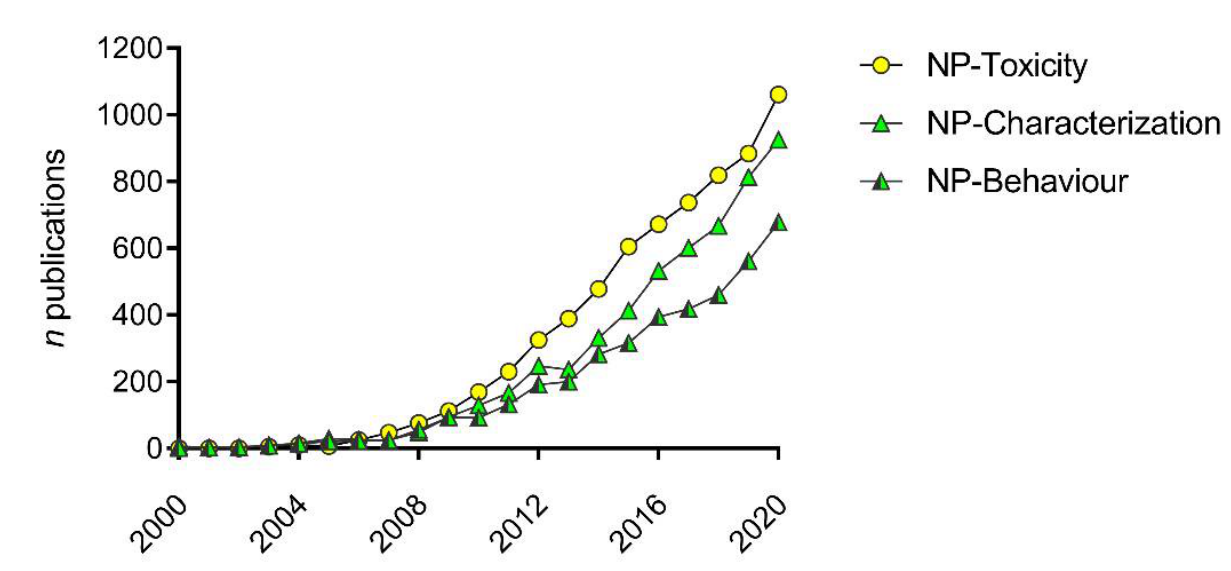
Figure 1. The importance of ENM/NP behavior (green) in nano-ecotoxicity studies (yellow) in the last 20 years (2010–2020). Data obtained from Scopus, search queries: ((TITLE-ABS-KEY(nanoparticles OR nanomaterials AND be- havior) AND DOCTYPE(ar) AND PUBYEAR > 1999 AND PUBYEAR < 2021) AND (LIMIT-TO (SUBJAREA,”ENVI”) OR LIMIT-TO (SUBJAREA,”AGRI”)))((TITLE-ABS-KEY(nanoparticles OR nanomaterials AND characterization) AND DOCTYPE(ar) AND PUBYEAR > 1999 AND PUBYEAR < 2021) AND (LIMIT-TO (SUBJAREA,”ENVI”) OR LIMIT-TO (SUBJAREA,”AGRI”)))((TITLE-ABS-KEY(nanoparticles OR nanomaterials AND toxicity) AND DOCTYPE(ar) AND PUB- YEAR > 1999 AND PUBYEAR < 2021) AND (LIMIT-TO (SUBJAREA,”ENVI”) OR LIMIT-TO